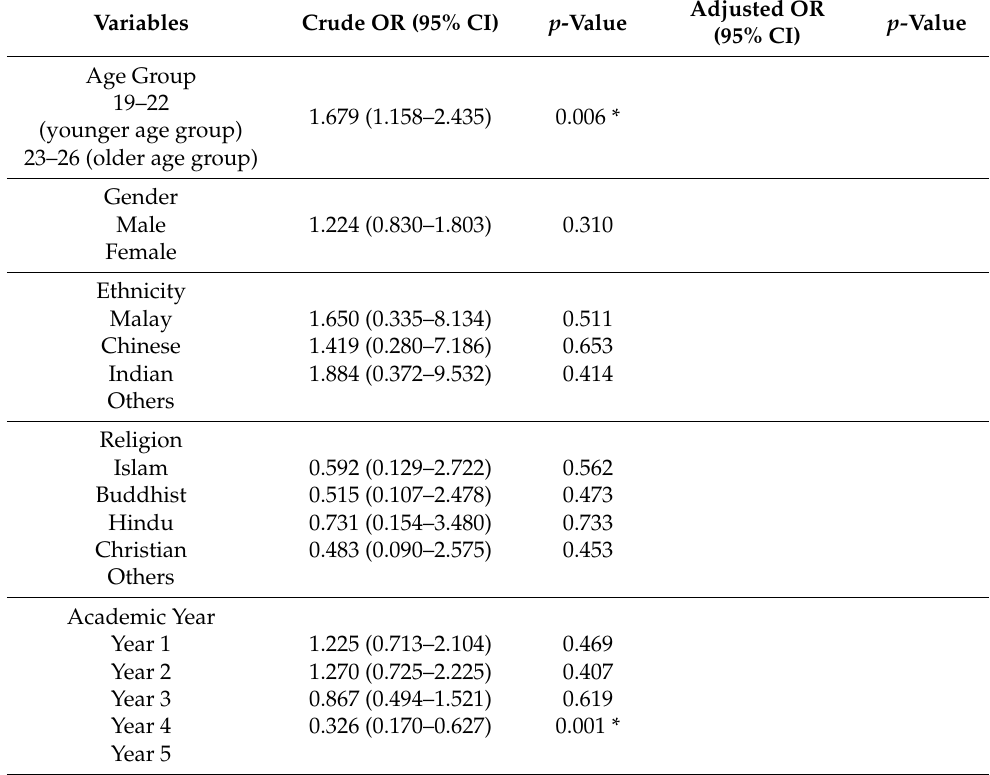
Table 5. Multivariate Ordered Logistics Regression Analysis between Variables and Anxiety among Medical